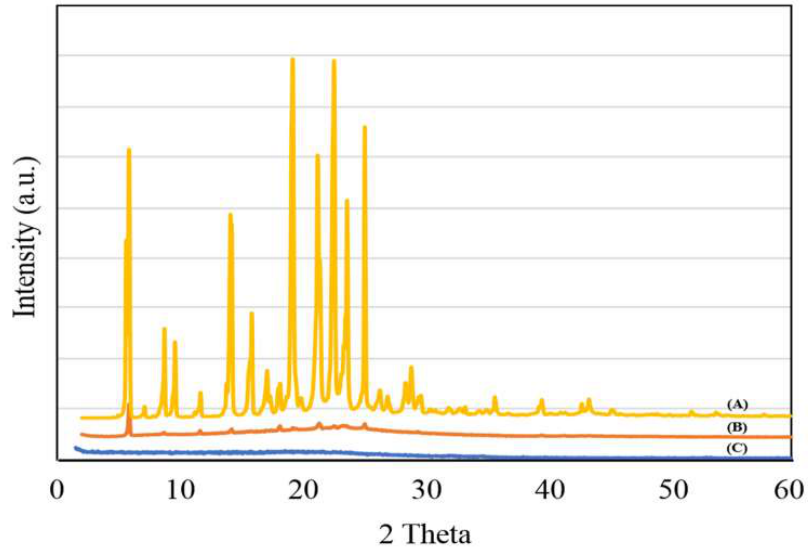
Figure 2. The XRD spectra for ( A ) free drug TAM, ( B ) PMMA-NR-Si-TAM and ( C ) silica.